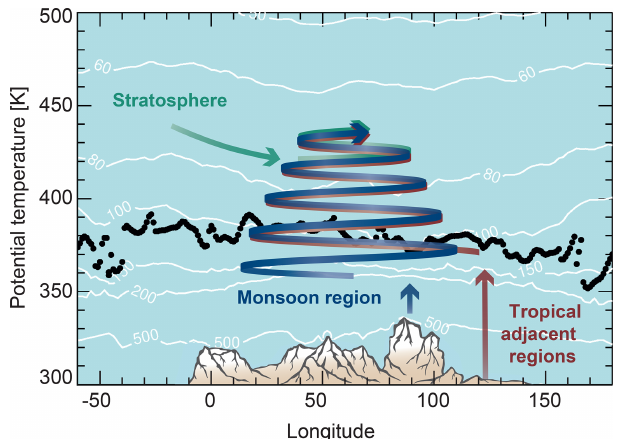
Figure 15. Longitude–theta cross section at about 30 ◦ N. At the top of the Asian monsoon anticyclone (above ∼ 360K) air masses circulate around the anticyclone in a large-scale upward spiral ex- tending from northern Africa to the western Pacific. In the upward spiralling range air masses from inside the Asian monsoon anti- cyclone (shown in blue) are mixed with air masses convectively uplifted outside the core of the Asian monsoon anticyclone in the tropical adjacent regions, e.g. uplifted by tropical cyclones in the western Pacific ocean (shown in red). The higher the air masses are above the thermal tropopause, the larger the contribution of air masses is from outside the Asian monsoon anticyclone from the stratospheric background coming into the upward spiralling flow (shown in green). The levels of pressure are marked by thin white lines and the thermal tropopause is shown by black